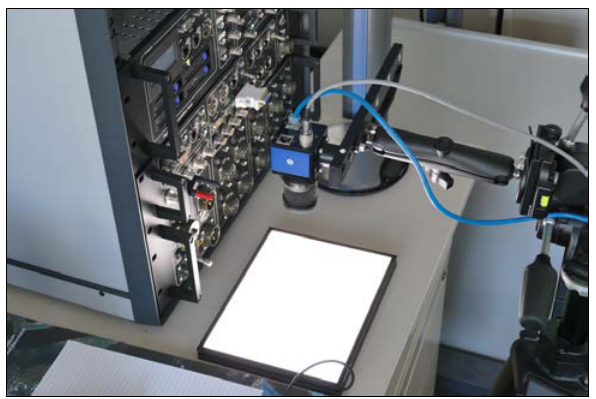
Figure 5: Custom-built „natural white LED“ flat field with frame imaging camera during daylight